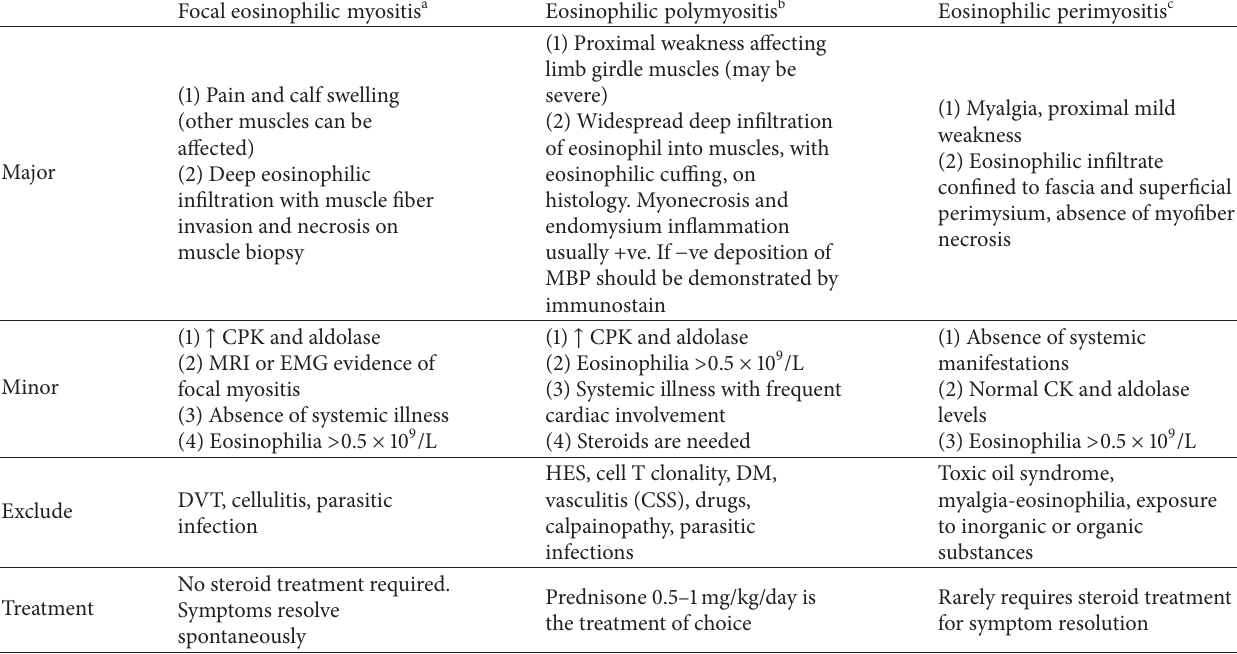
Table 3: Proposed criteria for diagnosis for eosinophilic myositis